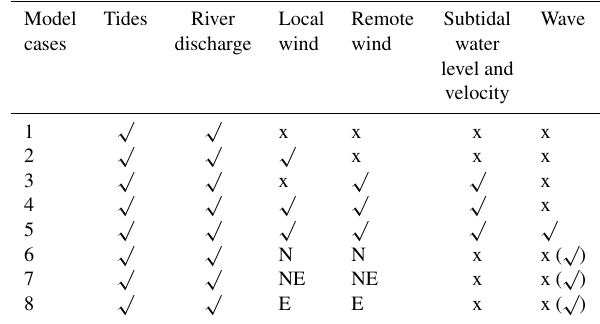
Table 1. Model simulation